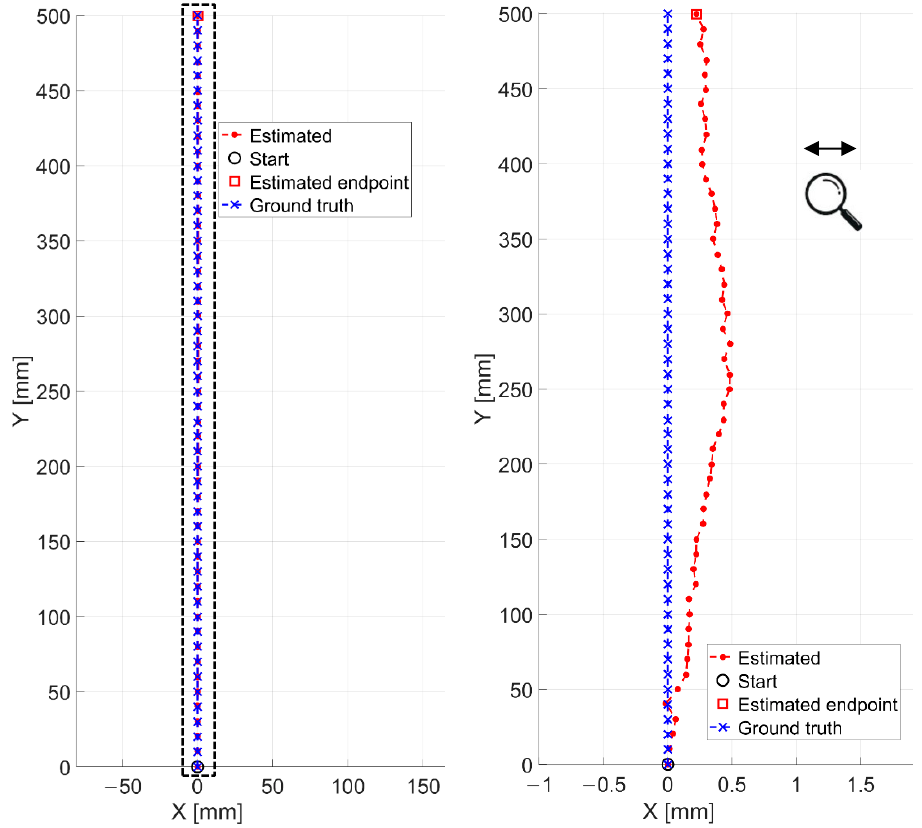
Figure 16. Estimated trajectory by our vision odometer (in red) and ground truth (in blue) related to the experiment IV. A zoomed in view (on the x-axis) is reported on the right for better appreciating differences among the two signals on the left (in dashed rectangle).